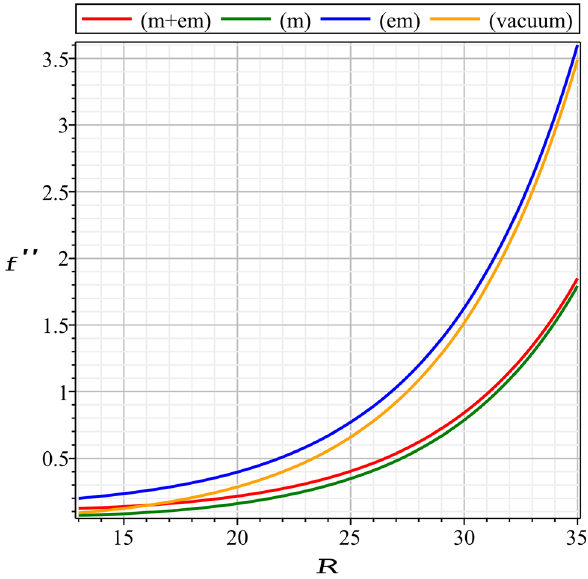
Fig. 8 This figure demonstrates the plot of f (cid:5)(cid:5) ( R ) for four options of interest(1–Pureelectromagneticcase(bluecolor);2–Puremattercase (green color); 3 – Both electromagnetic and matter cases (red color);